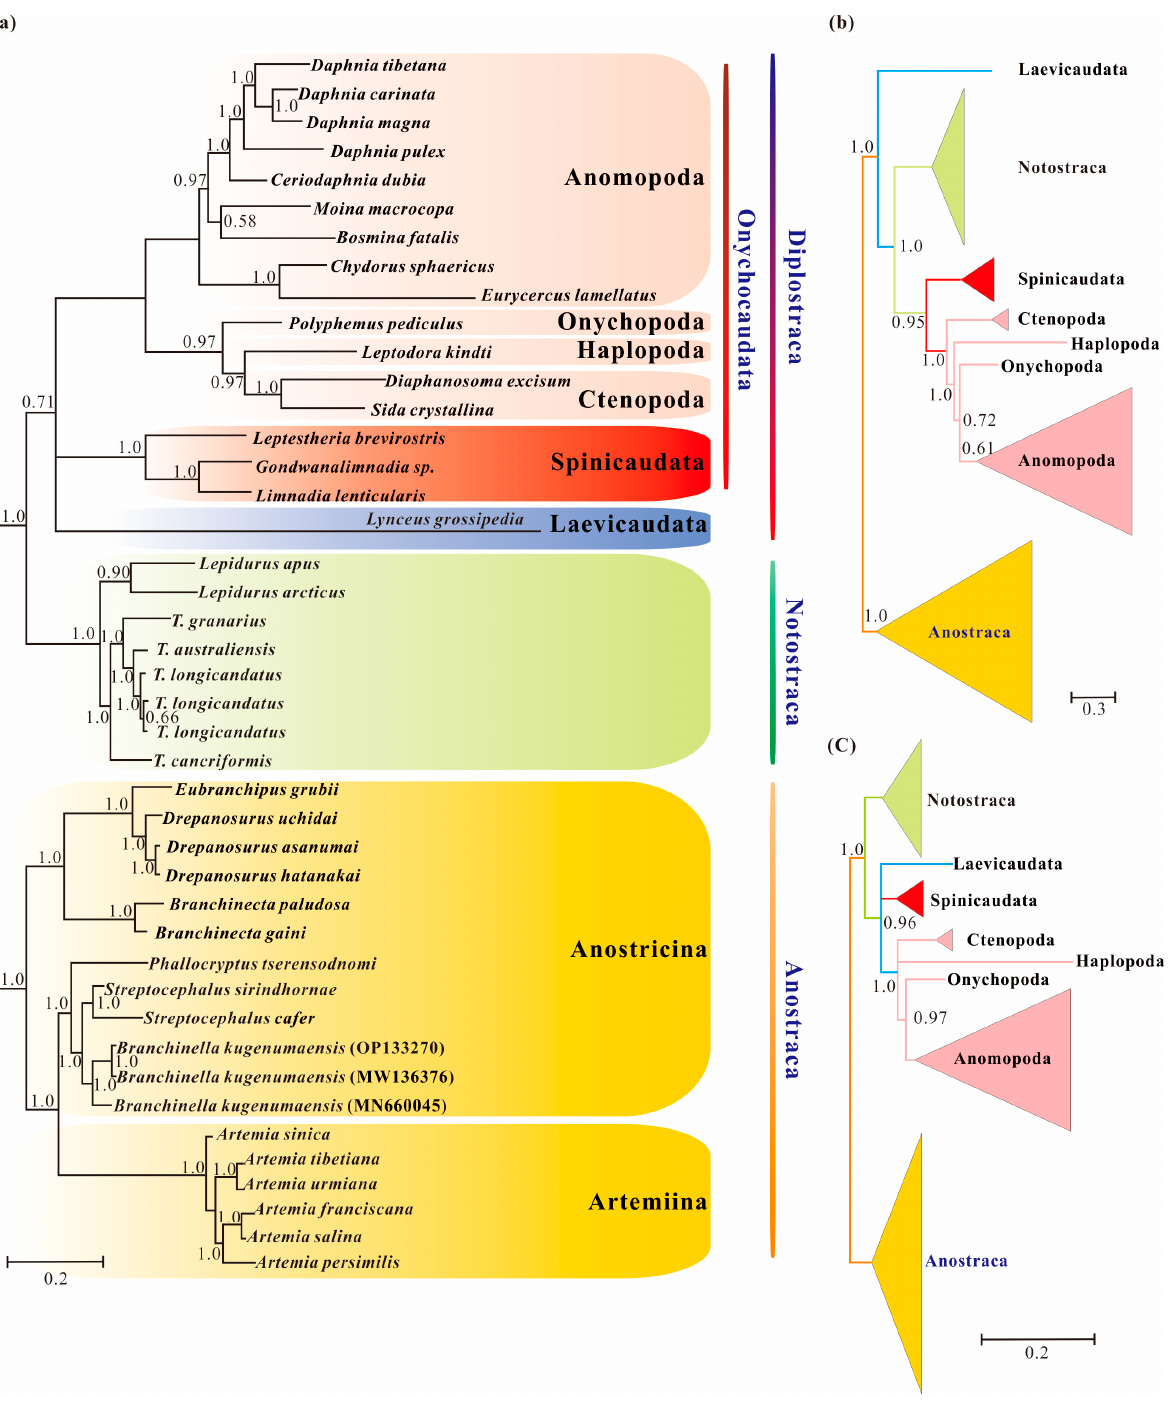
Figure 2. Branchiopod phylogenies inferred from the datasets of Pnuc6, Paa7 and Paas7 under the site-heterogeneity models obtained with PhyloBayes: ( a ) Bayesian tree from the dataset of Pnuc6; ( b ) Bayesian tree from the dataset of Paa7; ( c ) Bayesian tree from the dataset of Paas7. The Bayesian trees based on the datasets of Paa7 and Paas7 are shown in b and c as a schematic version with some lineages collapsed for clarity. Supports at nodes are Bayesian posterior probabilities.